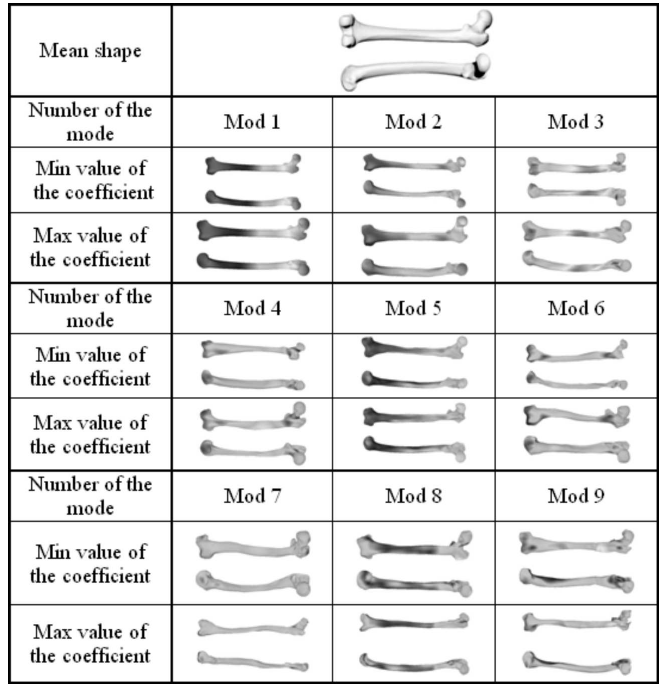
Figure 7. 3D visualization of mean value and first nine modes of femur bones (anterior and posterior